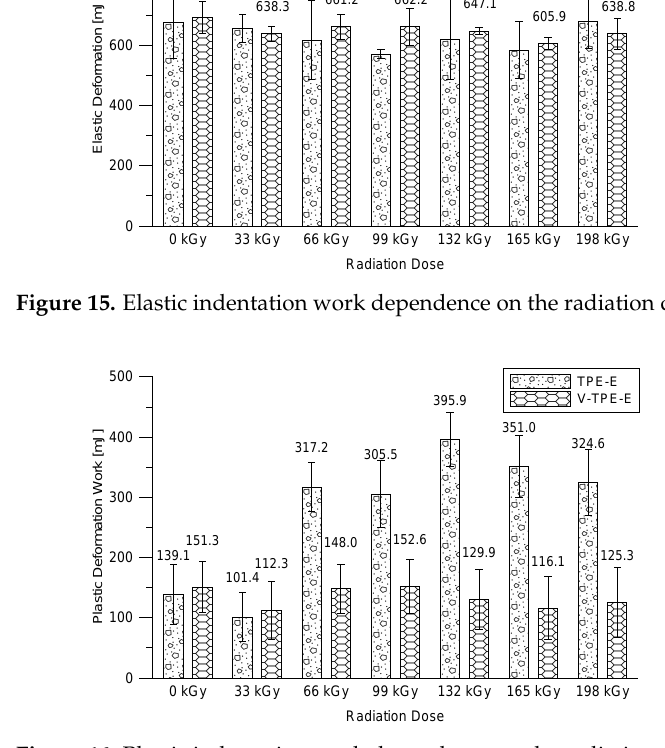
Figure 16. Plastic indentation work dependence on the radiation